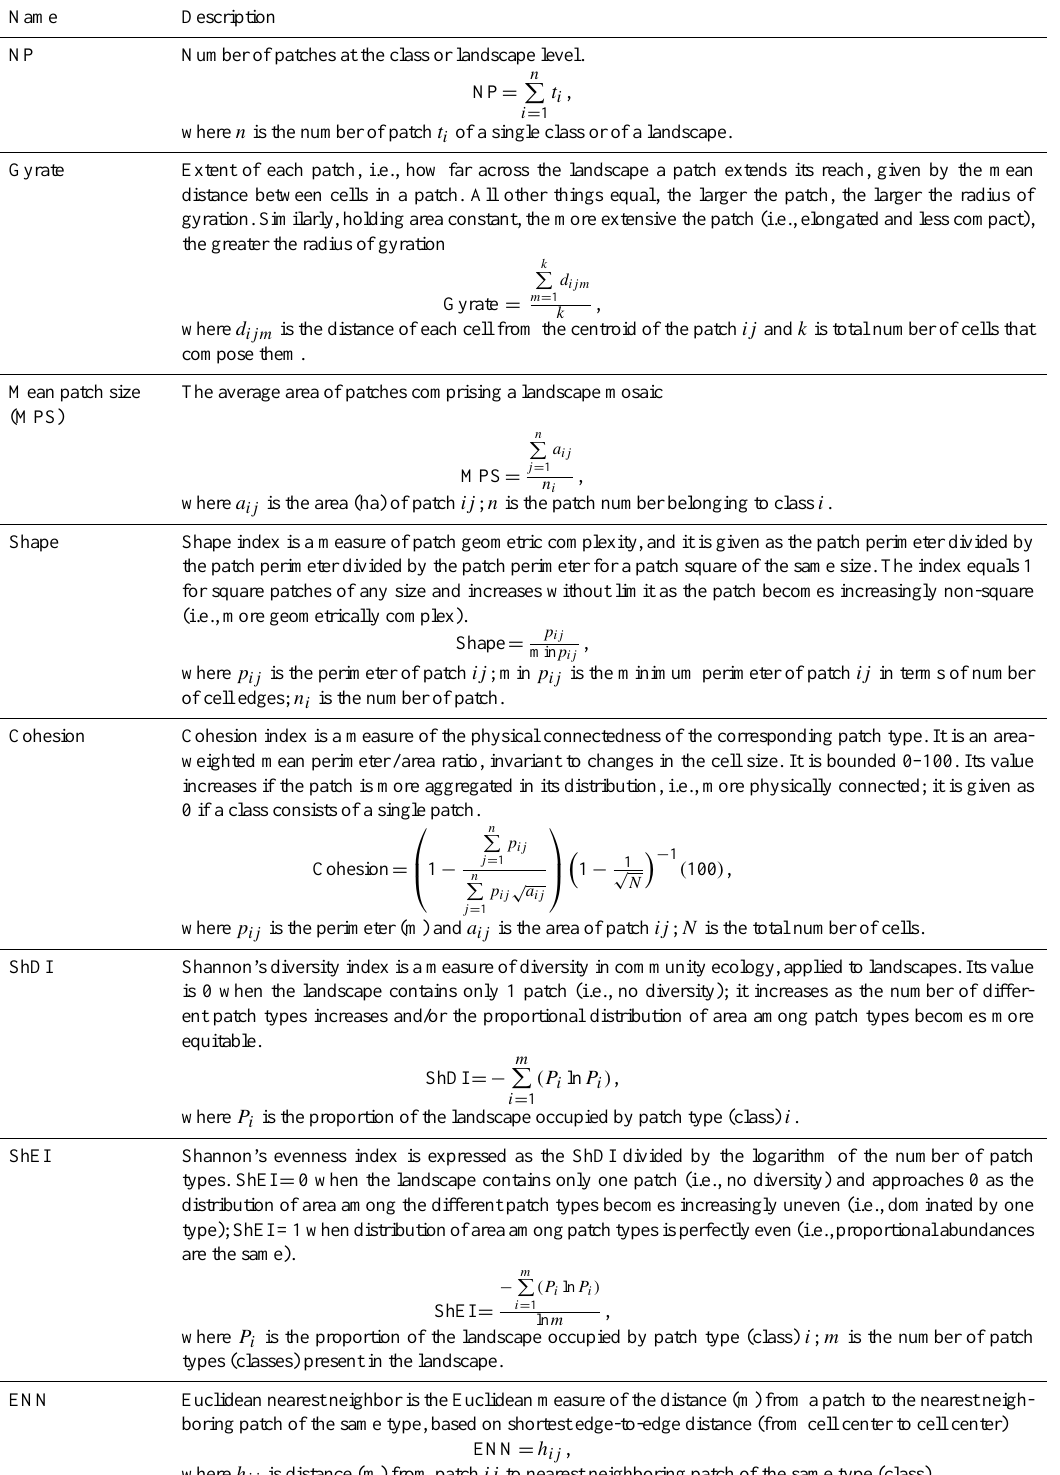
Table 1. Landscape metrics indicators selected for evaluating the study area composition and configuration at landscape and class